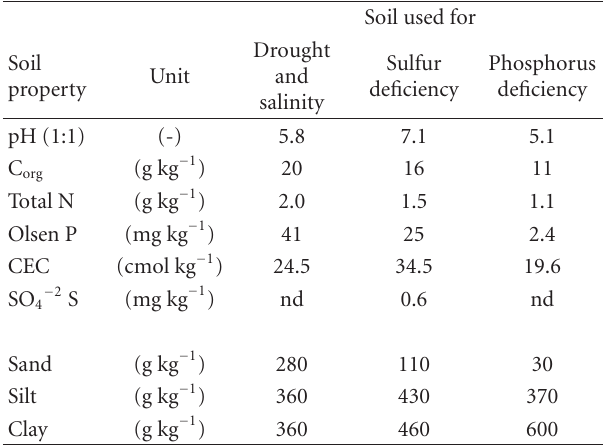
Table 2: Some characteristics of the soils used for the four di ff erent abiotic stresses